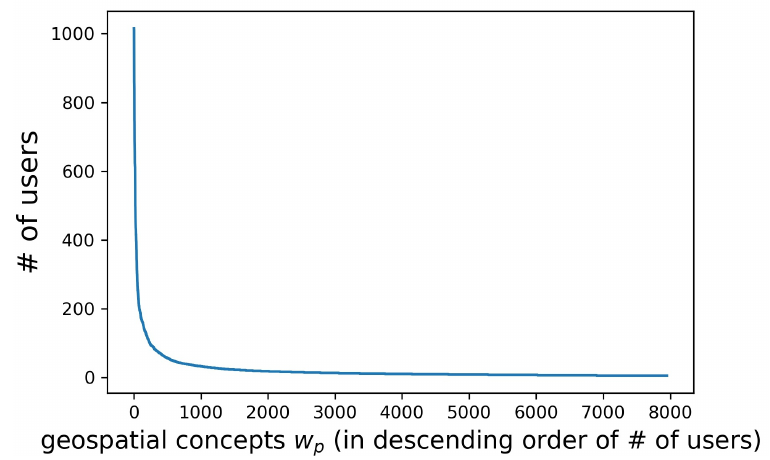
Figure 7. Number of users for extracted geospatial concepts w p , where w p is ranked in the descending order of the number of users. Examples of the geospatial concepts used by more than 100 users are mostly names of states, big cities, or popular places such as manhattan , centralpark , chinatown , and hollywood .